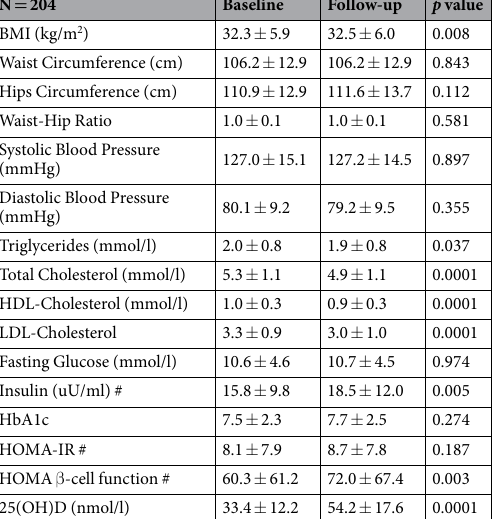
Table 1. Anthropometrics and biochemical characteristics of all T2DM subjects at baseline and after 12 months of vitamin D supplementation. Note: Data were presented as mean ± standard deviation. # log-transformed prior to analysis. BMI- Body mass index; HOMA-IR- Homeostasis model assessment for insulin